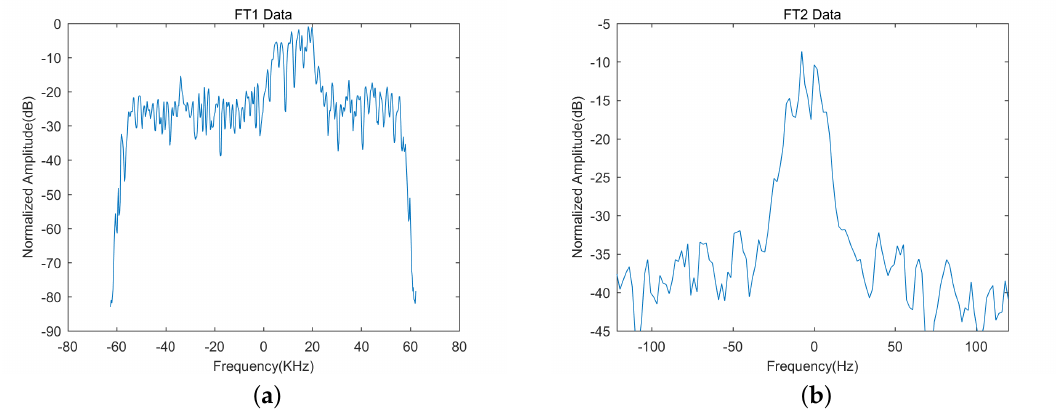
Figure 4. Example of FT1 data and FT2 data. The data are applied 3-point smooth. ( a ) FT1 data of 56th echo. ( b ) FT2 data of 56th range cell (420 m far from